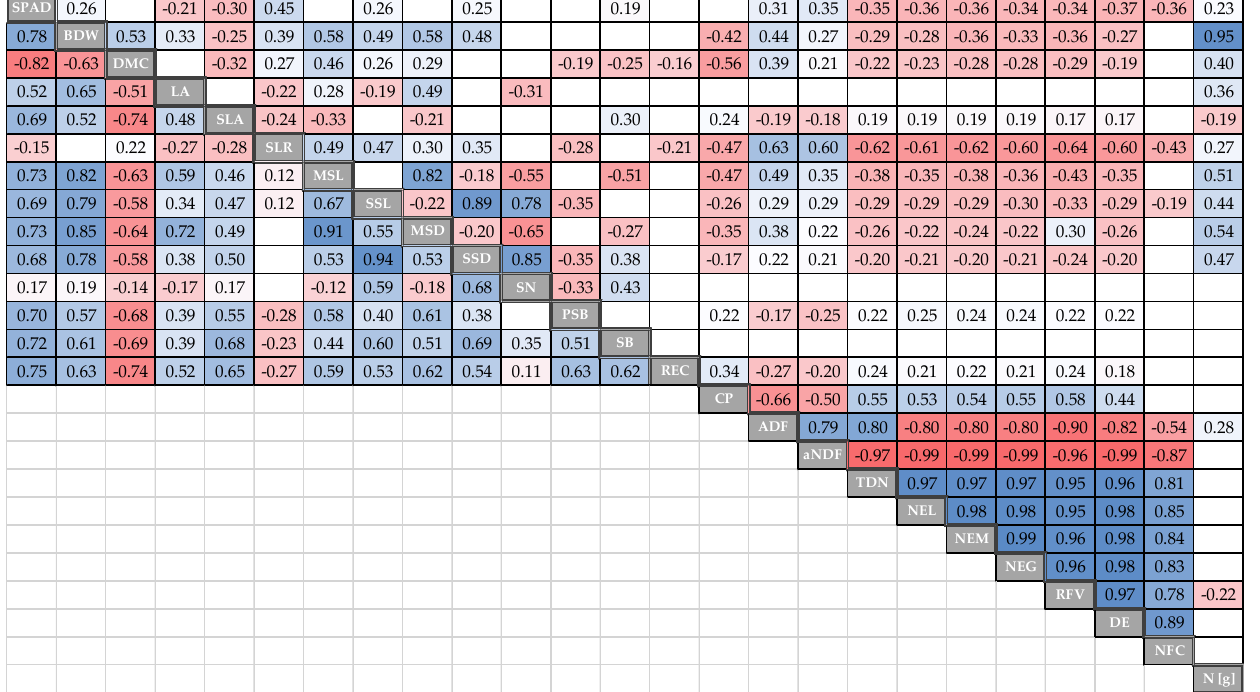
Figure 4. Correlation analysis for control group (below diagonal) and fertilizer group (above diagonal) among biomass productivity traits, morphological characteristics, and nutritional value. Significant correlations were set at a confidence level of 0.95, and blank cells represent no significant correlations. See Table 2 for abbreviations.